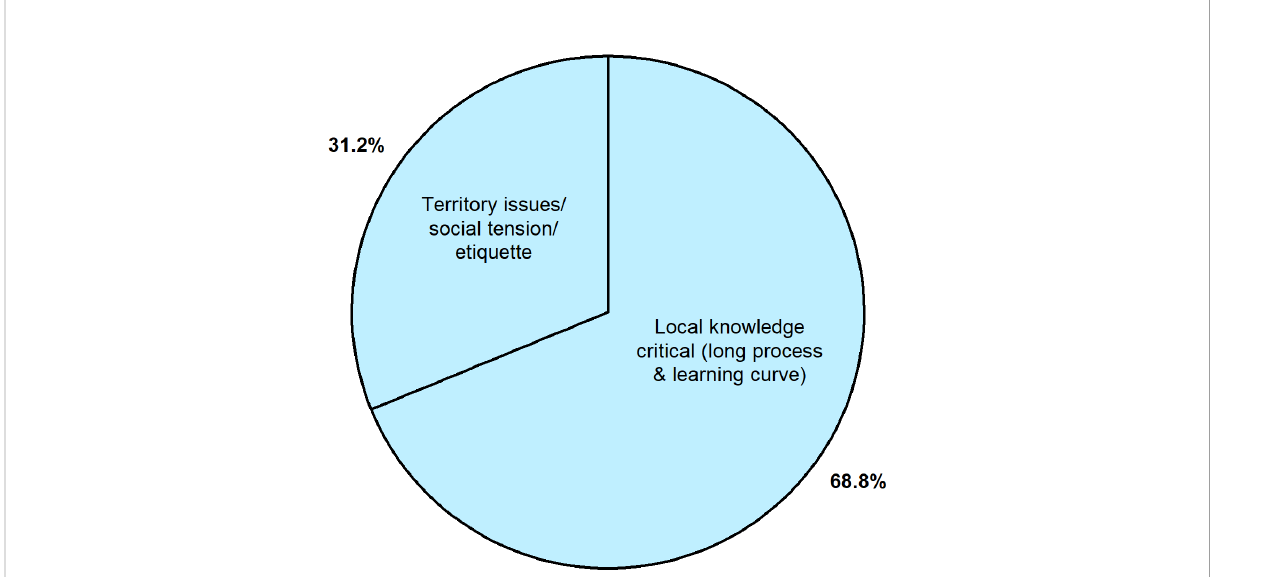
FIGURE 8 Themes from open-ended responses from spiny lobster fi shermen who chose to elaborate on locational knowledge-related constraints to adaptive capacity (n=16). Responses by market squid fi shermen (n = 5) are not displayed as a pie chart given that 100% of fi shermen who elaborated cited the importance of local ecological